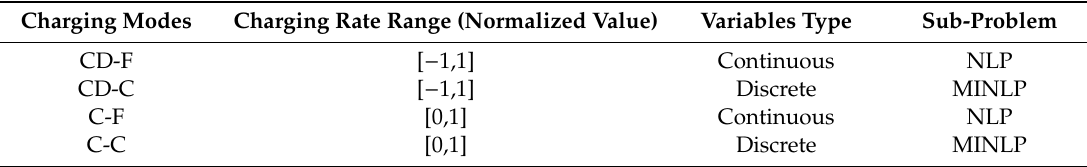
Table 1. Comparisons for the four charging